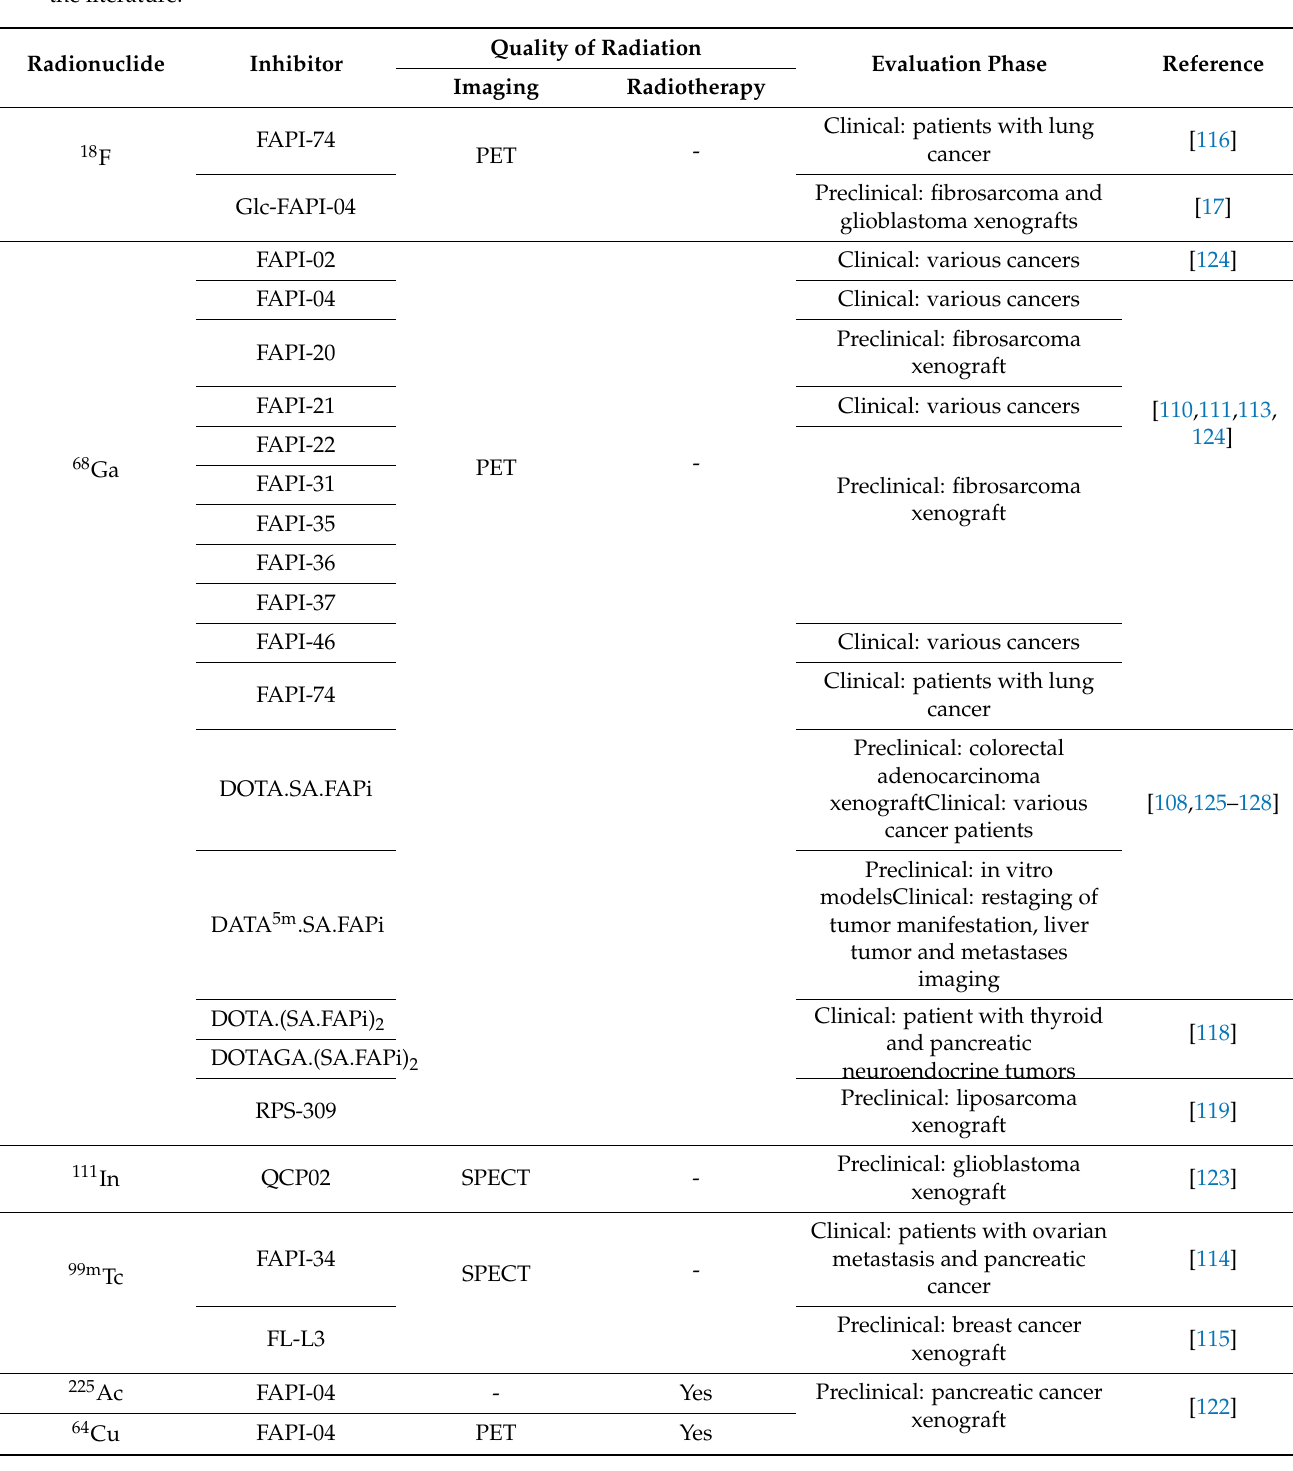
Table 2. Overview of important radiopharmaceutical-based FAP tracers for nuclear imaging and radiotherapy reported in the